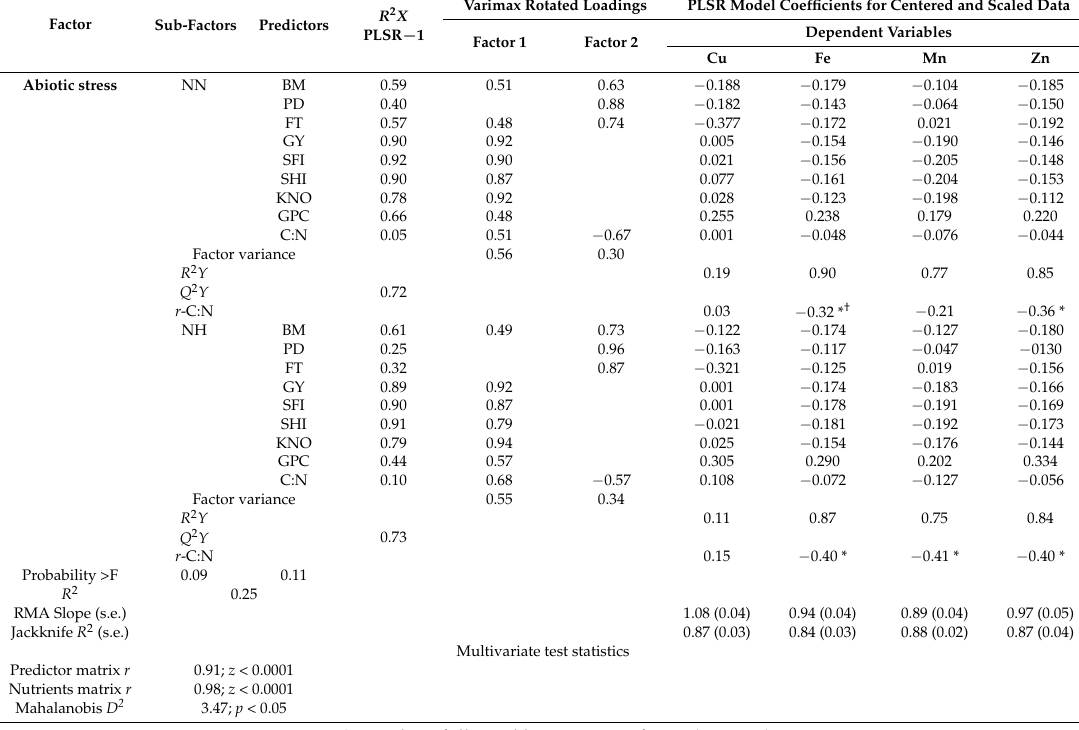
Table 6. Multiple comparisons between two abiotic stress levels (NN: normal length of growing season and population density, and NH: normal length of growing season and high population density) of T. aestivum and T. durum , using partial least squares regression (PLSR), factor analyses, prediction of micronutrients as functions of phenotypic plasticities, multivariate distances, and matrix correlations between predictors and between predicted